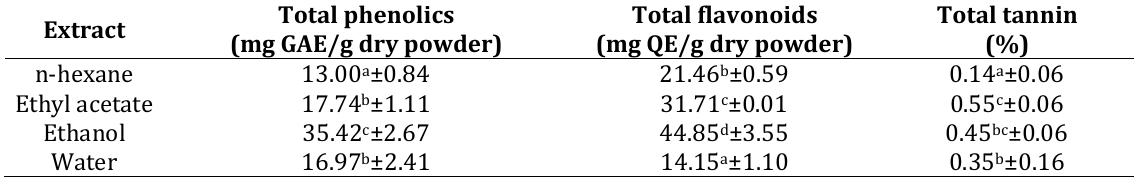
Table I. The total phenolics, flavonoids and tannin content in the four extract of G. ulmifolia leaves (n = 3) Extract